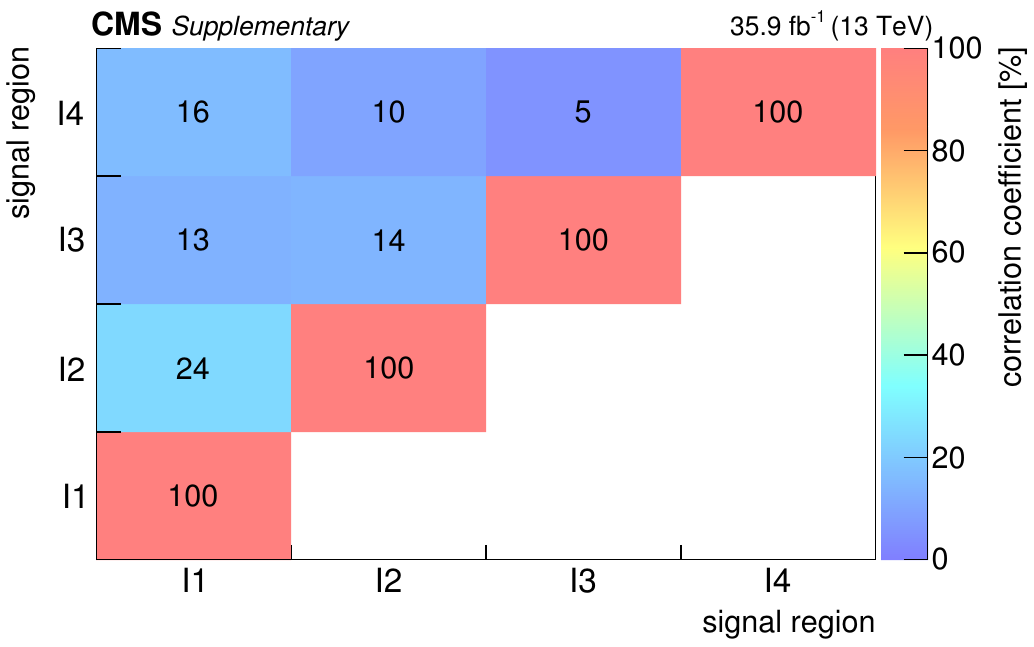
Figure 9 . Correlation matrix for the background predictions for the signal regions for the com- pressed selection (in percent). The labelling of the regions follows the convention of (cid:12)gure